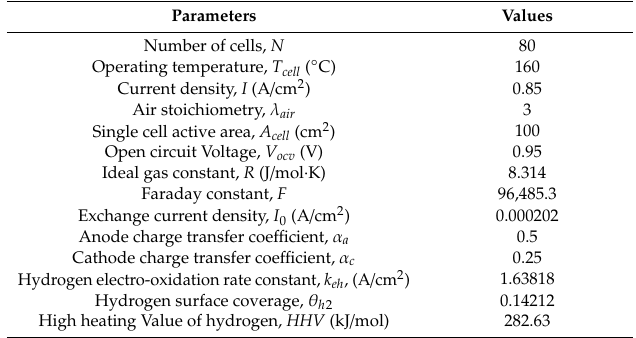
Table 1. Operating parameters and empirical parameters used in HT-PEMFC model.